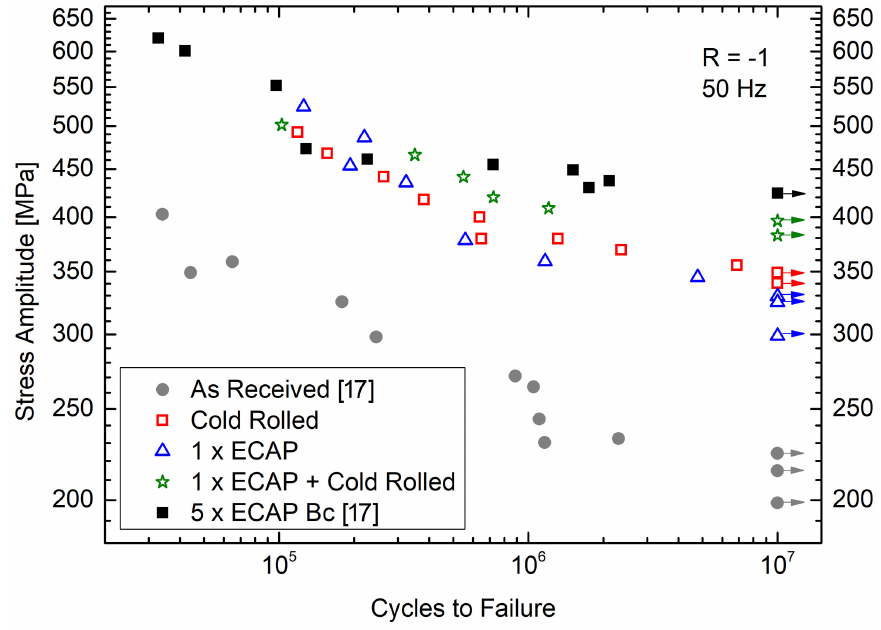
Figure 5. S – N diagrams for ARMCO ® iron in different processing conditions under four-point rotating bending loads.